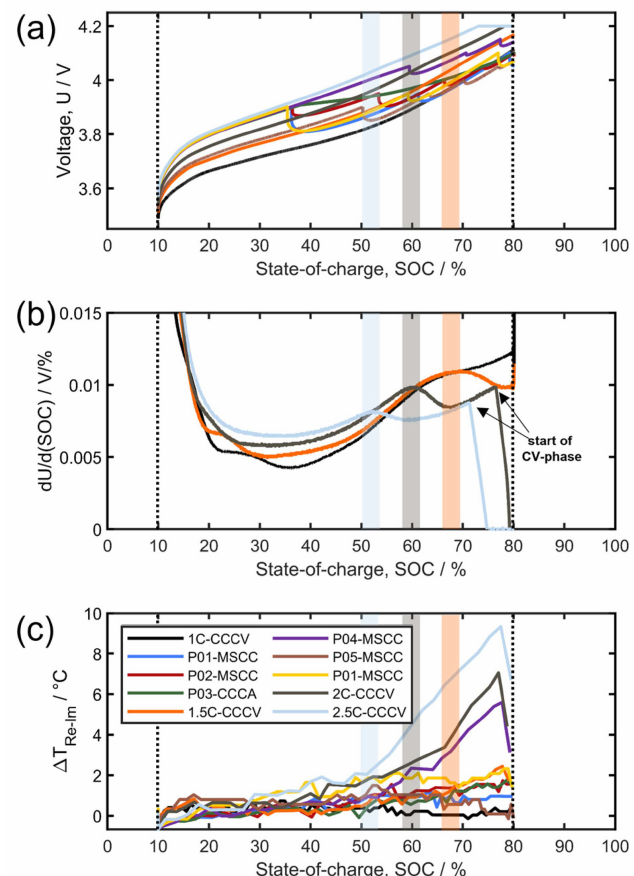
Figure 3. Fast charging with different profiles at a 25 ◦ C initial temperature, ( a ) cell poten- tial, ( b ) differential charging voltage analysis of the CCCV-charging profiles, and ( c ) respective ∆ T Re − Im